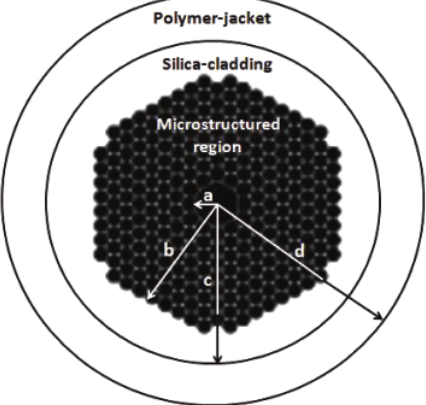
Figure 1: Cross-section of the investigated HC-PBF with an air- core, a microstructured air-silica inner cladding, a solid silica outer cladding, and a polymer coating, where (a–d) represent the radius of each